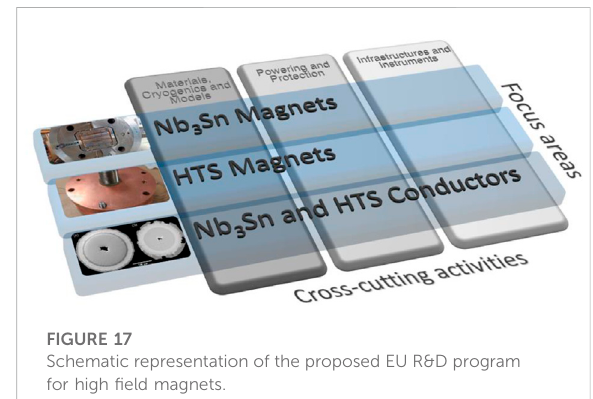
FIGURE 17 Schematic representation of the proposed EU R&D program for high fi eld